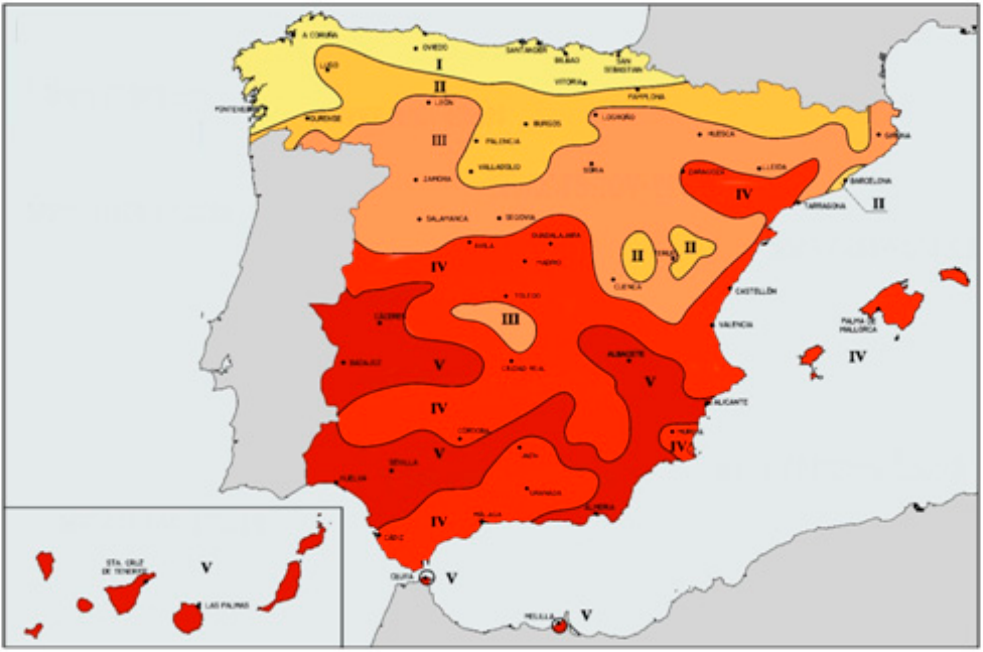
Figure 6. Spanish solar radiation climatic zones.Source: Código Técnico de la Edificación [45].